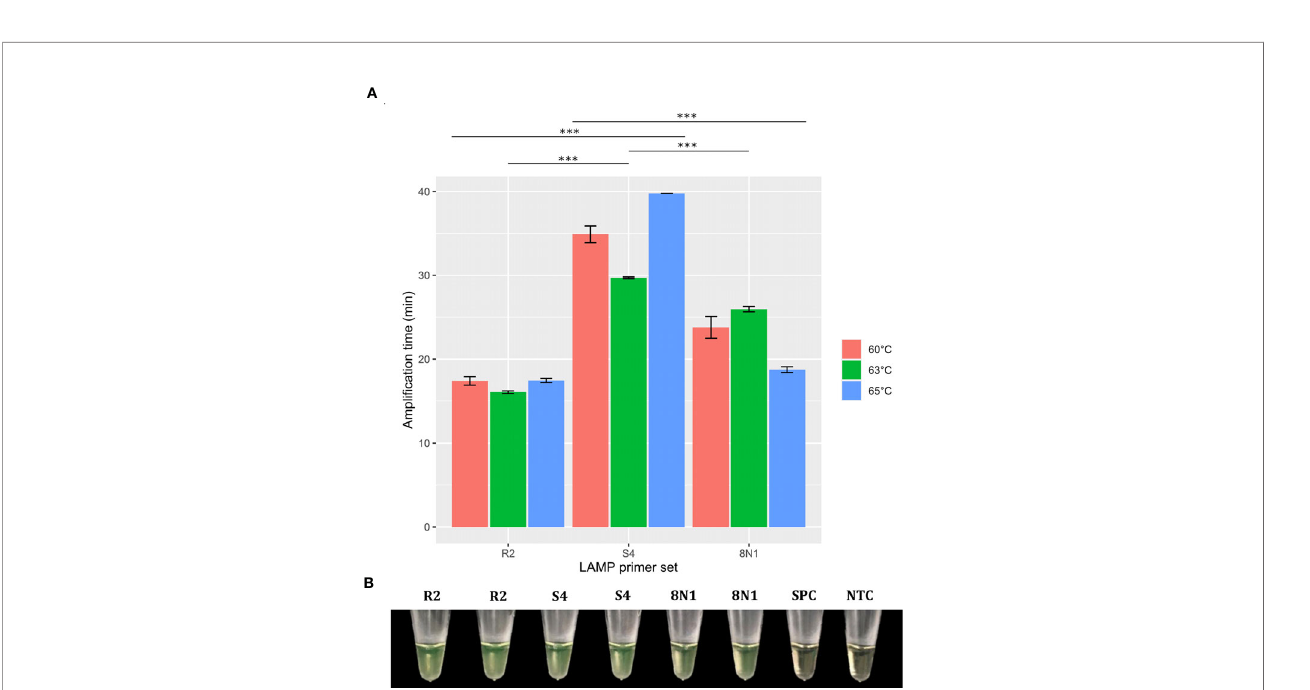
FIGURE 5 | Effect of temperature and R2, S4, and 8N1 primer sets on RT-LAMP assay performance. Error bars represent the standard deviations of the ampli fi cation time mean from independent experiments performed in duplicate. ***P < 0.001. Signi fi cance analyzed by one-way analysis of variance (ANOVA) (A) . RT- LAMP assays using the R2, S4, and 8N1 primer sets for SARS-CoV-2 detection were considered positive when the solution color changed from brown to green (B) . NTC, negative non-template control; SPC, SARS-CoV-2 positive